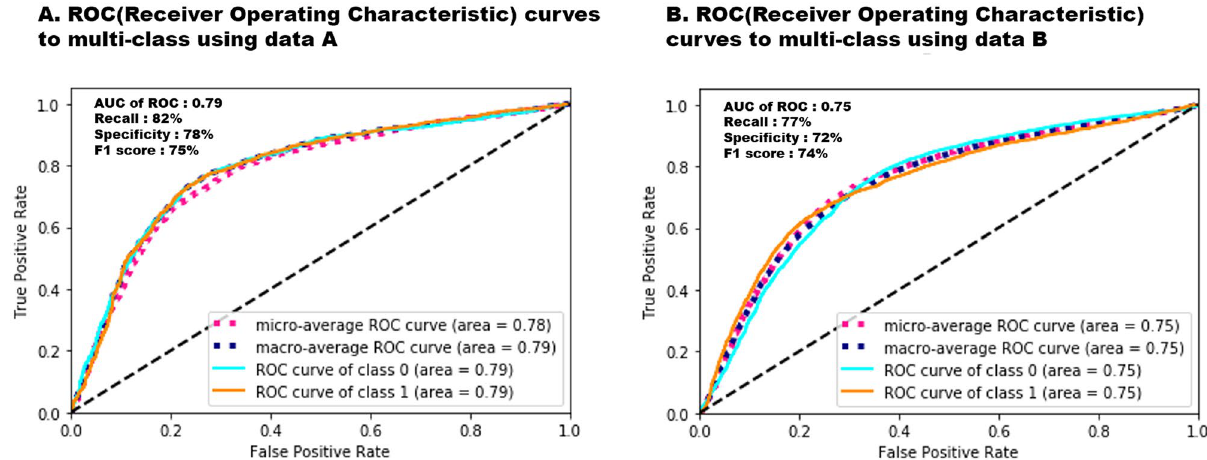
Figure 2. Multiclass ROC curves with deep neural networks applied in the internal and external datasets. The micro-average and macro-average AUC derived from the ROC curve of the AI algorithm is calculated during the internal and external validations (0.78 [95% CI 0.76–0.80], 0.79 [95% CI 0.78–0.80] for internal validation dataset; 0.75 [95% CI 0.74–0.76], 0.75 [95% CI 0.74–0.76] for external validation dataset). ROC receiver operating characteristic; AUC area under the ROC curve. Class 0: healthy-NSR, Class 1: